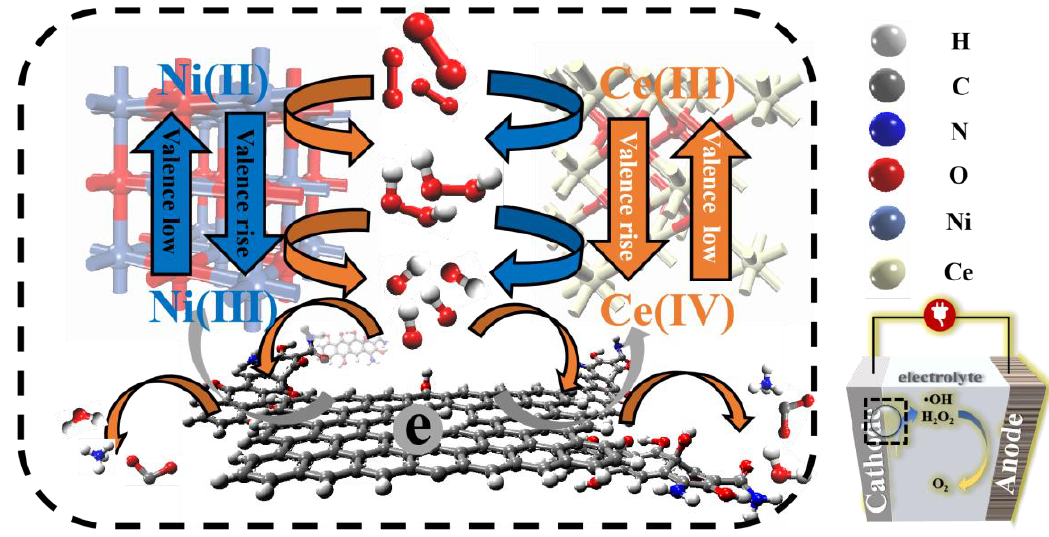
Figure 8. Schematic diagram of the electrocatalytic